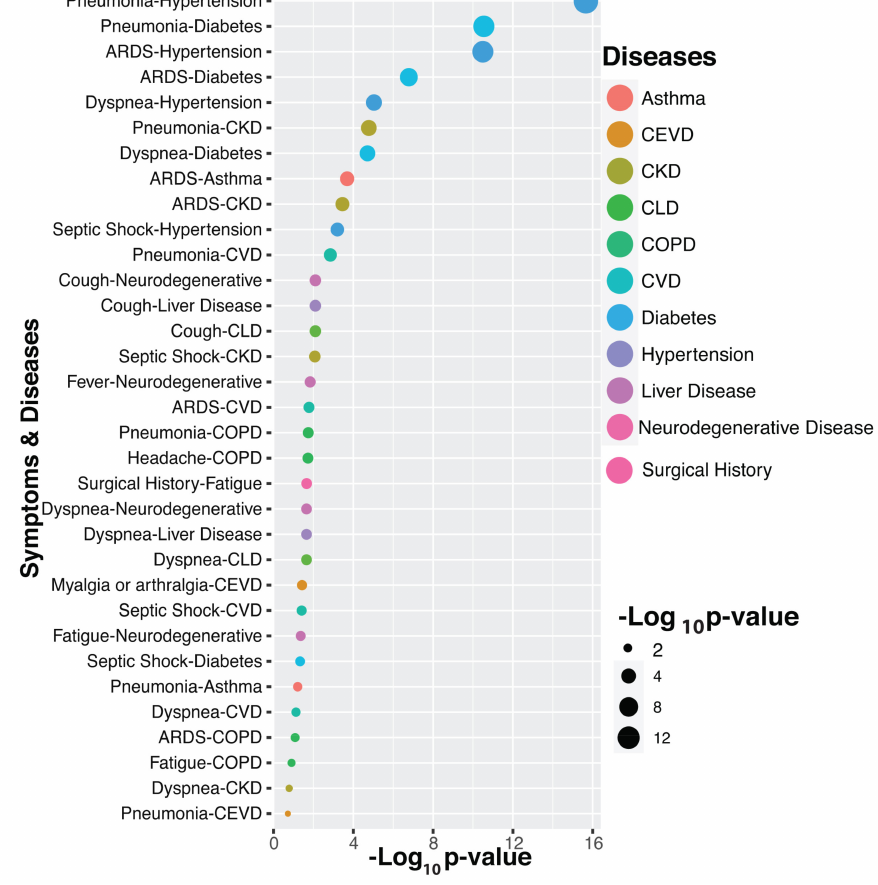
Figure 3. Association and impact of combined symptoms and ccomorbidity interactions in COVID-19 deceased